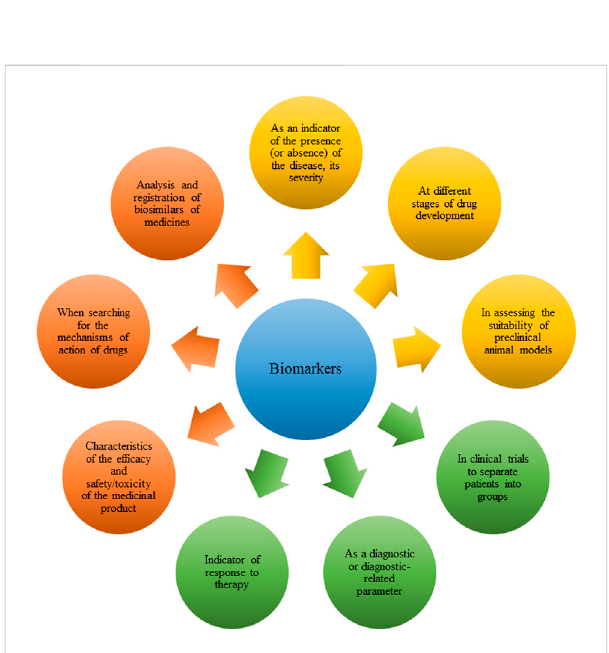
FIGURE 1 Indications for the use of biomarkers in various diseases, including in gastric cancer